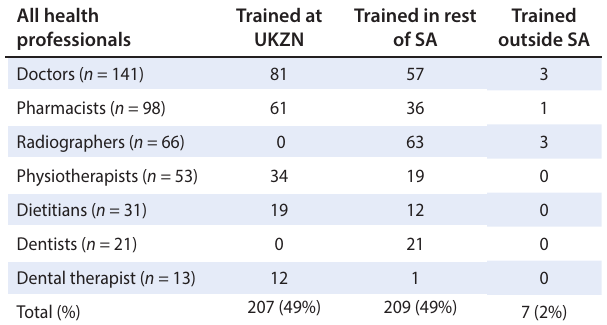
Table 2: Training location of the DH healthcare professionals ( n = 423) All health professionals